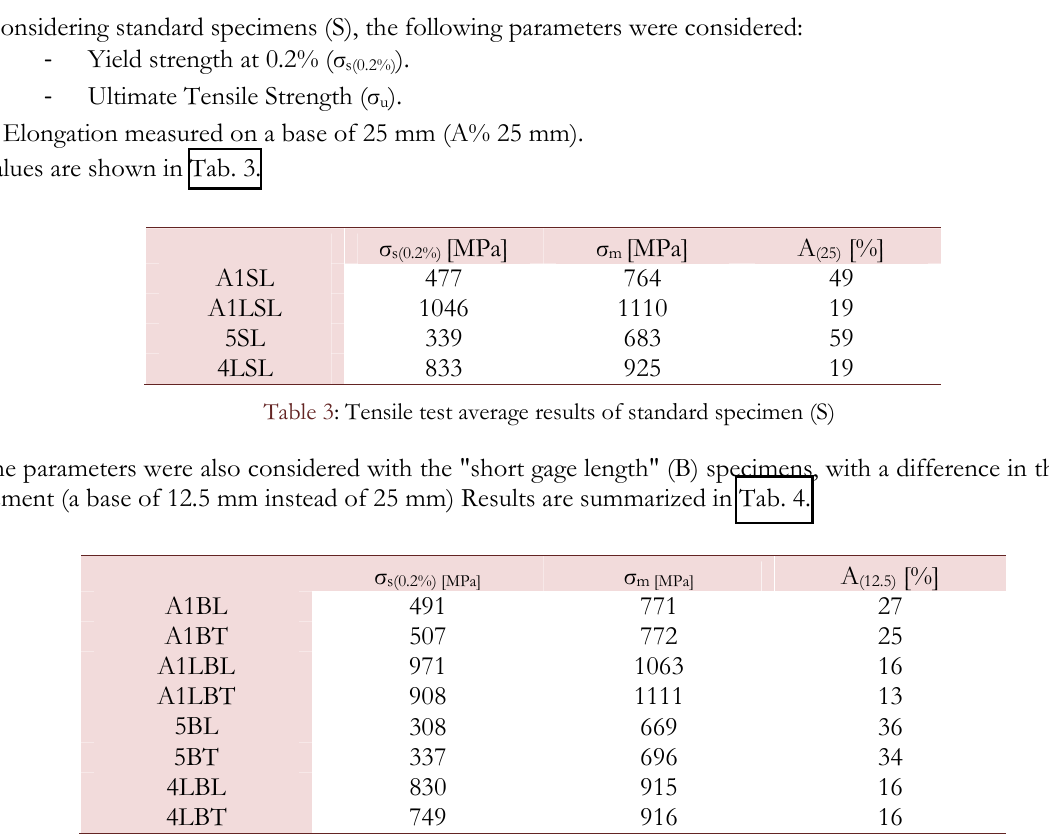
Table 4: Tensile test average results of short gage length specimen (B).